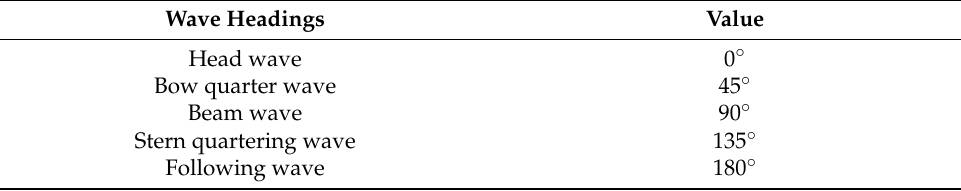
Table 2. Definition of wave headings.